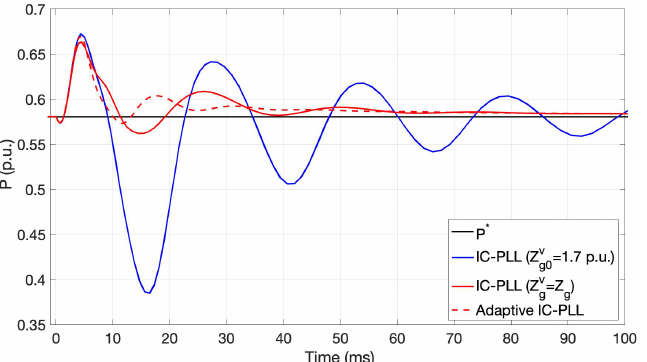
Figure 11. Time-domain response of the active power for different types of PLLs for step change in Z g = 1.7 2 p.u. and for ω FL , PLL = 400 rad/s (inverter operation). →